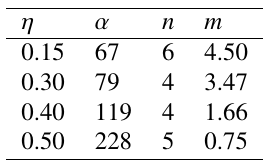
Table 1. van Genuchten fitting